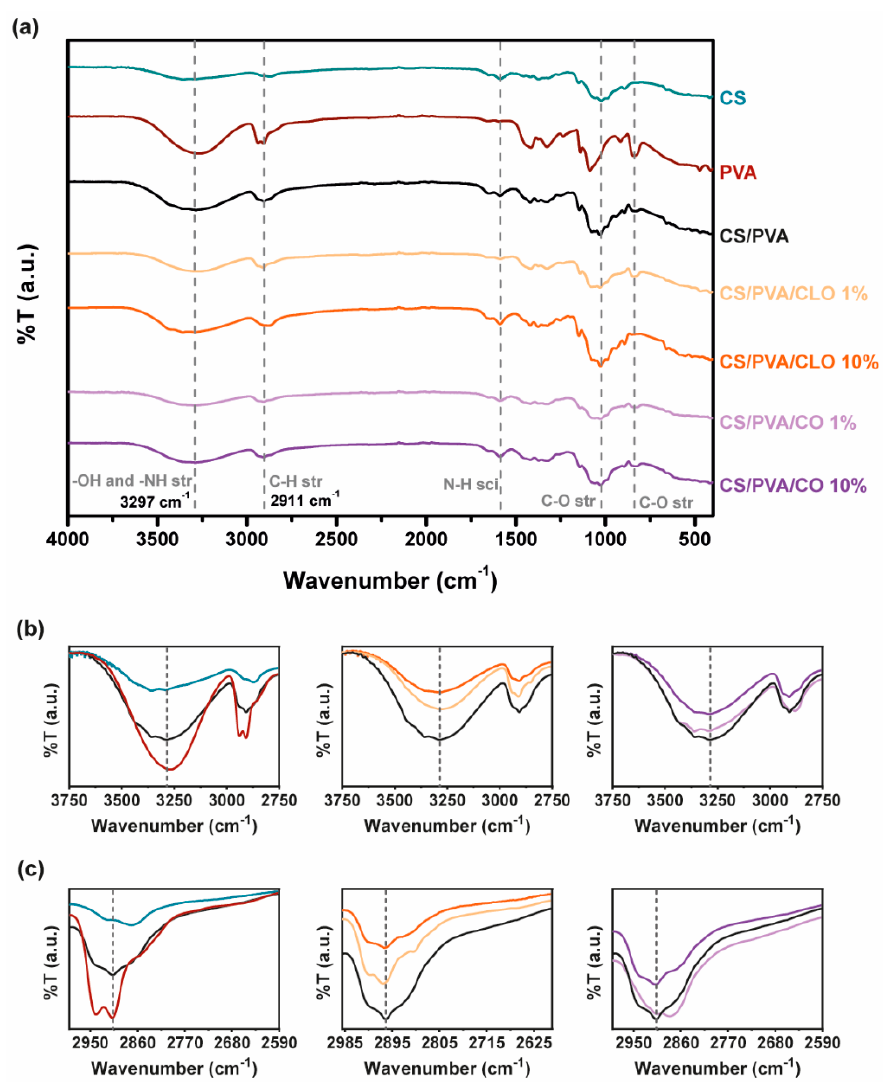
Figure 4. ( a ) FTIR-ATR spectra of the EO-unloaded and loaded CS/PVA-based blended films (4000–400 cm − 1 ). Sections between ( b ) 3750–2750 cm − 1 and ( c ) 2990–2590 cm − 1 were amplified for a clearer detection of the most relevant peaks.